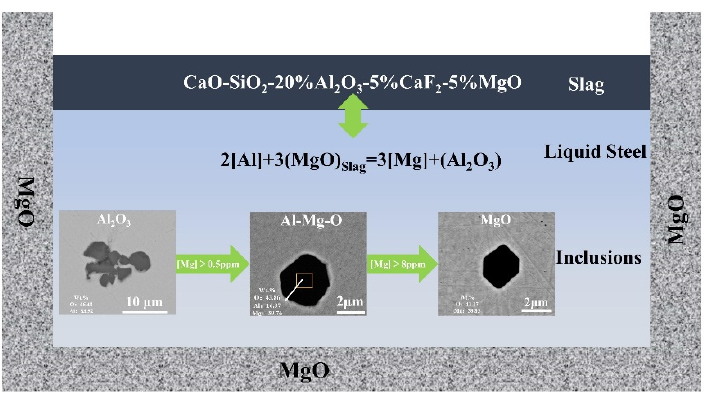
Figure 14. The CaO-MgO-SiO 2 -Al 2 O 3 -CaF 2 slag and inclusion reaction evolution mechanism in 15- 5PH stainless steel.